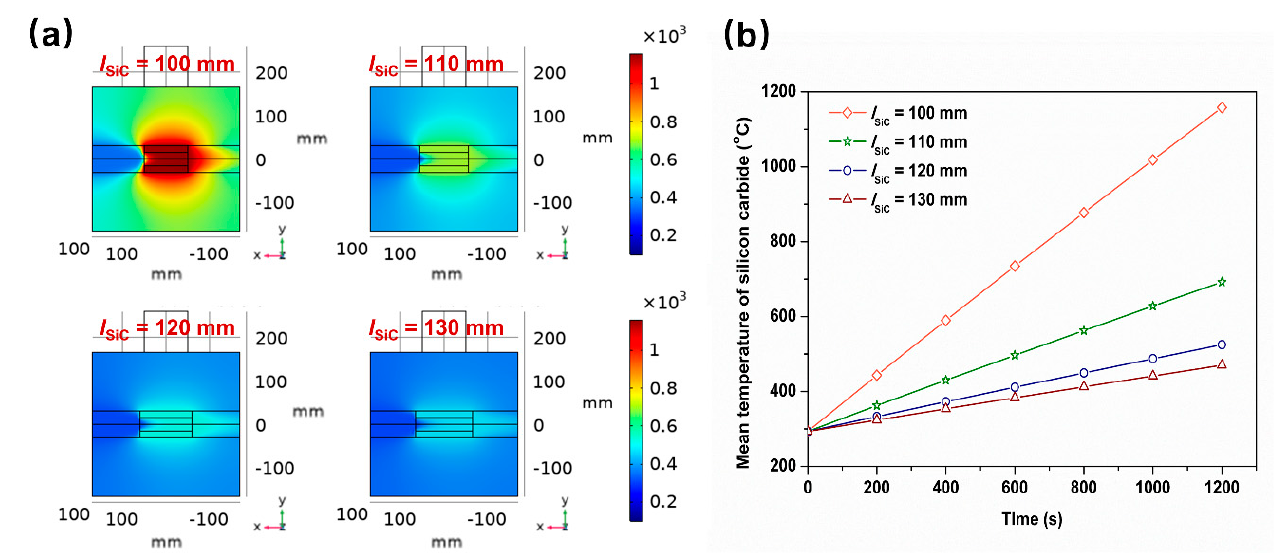
Figure 8. Effect of silicon carbide bed length on the simulated thermal fields (the temperature unit: K; x – y plane, z = 0; z i = 5 mm; P = 1000 W; v = 0.02 m/s): ( a ) variation of the thermal fields with different silicon carbide bed lengths; and ( b ) the heating rate of silicon carbide under microwave irradiation with different silicon carbide bed lengths.